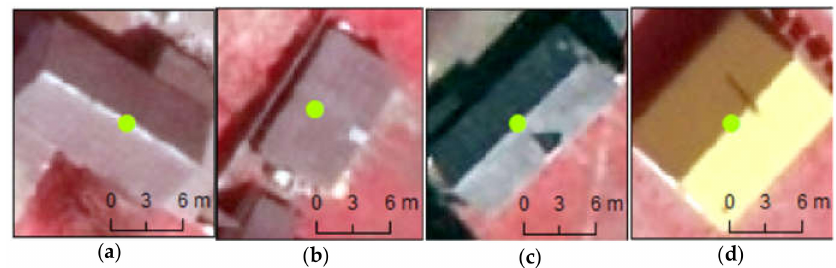
Figure 3. Example image signatures for investigated types of roof cover materials: ( a )